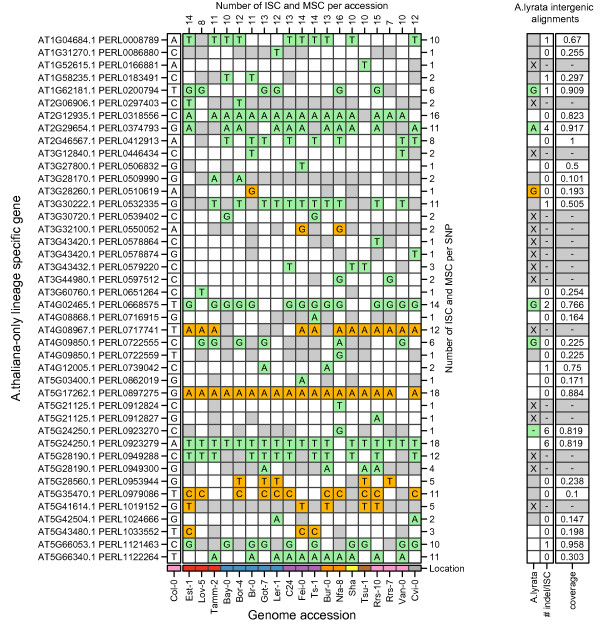
Distribution of SNPs causing interruptions to the ORFs of LSGs in various Arabidopsis thaliana accessions. Predicted SNPs predicted by Perlegen re-sequencing data sets that cause the interruption of an LSG ORF. Left hand axis: lists the gene model and the SNP name. Left hand column: Lists the reference nucleotide found in the Columbia accession (Col-0). Main body of table: SNPs causing a missing of a start codon (MSC) are coloured orange. SNPs causing an internal stop codon (ISC) are coloured green. Missing data (i.e. when the nucleotide is undetermined at that position) coloured gray. Only SNPs causing ISC or MSC are annotated. Bottom axis: lists the accessions tested, they are divided by broad geographical distinctions; i.e. red = Northern Europe, blue = Central Europe, purple = Mediterranean, orange = British Isles, yellow = Central Asia, brown = Japan, pink = North America and gray = Cape Verde Islands. Right hand columns: First column represents the SNP data at the position for the intergenic alignment between the LSGs and intergenic regions in Arabidopsis lyrata. SNP types marked the same as the main table with the addition of an "X" representing those instances were no alignment was identified in Arabidopsis lyrata. The second column represent the total number of ISC and indels found in the aligned Arabidopsis lyrata sequence. The final column represents the proportion of the LSG that is covered by the Arabidopsis lyrata alignment.